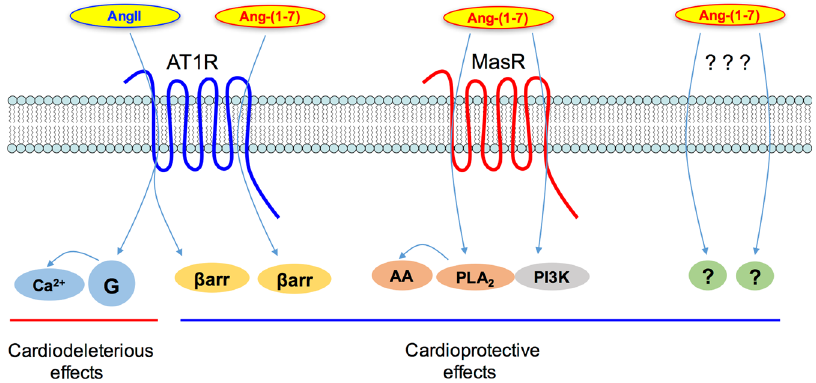
Figure 4. Schematic representation of the possible mechanism by which Ang-(1-7) plays its protective role in cardiac hypertrophy. AT1R is the main receptor for AngII, a GPCR coupled to G q that leads to calcium release and modulation of signaling pathways related to cardiodeleterious effects, including cardiac hypertrophy. Besides G protein activation, AngII binding to AT1R also leads to β -arrestin recruitment, impairing G protein signaling and inducing receptor internalization. AT1R coupling to β -arrestin also initiates a subset of arrestin- dependent signaling pathways, which have been involved in cardioprotective effects. Ang-(1-7) is known as the Mas receptor endogenous ligand, reported to trigger some of its signal transduction by activation of PLA2/ AA and PI3K/AKT 11,68–70 , exerting physiological outcomes that counteract the AngII/AT1R cardiodeleterious effects. Here we show that Ang-(1-7) also binds to AT1R, but in a β -arrestin biased fashion, leading to attenuation of cardiac hypertrophy. These data suggest that some of the known cardioprotective Ang-(1-7) effects may also occur due to activation of AT1R in a β -arrestin-biased way. Indeed, our data show that the individual blockage of either AT1R or Mas receptor with their selective antagonists was not able to revert the cardioprotective effects induced by Ang-(1-7). The combined use of both AT1R and Mas receptor